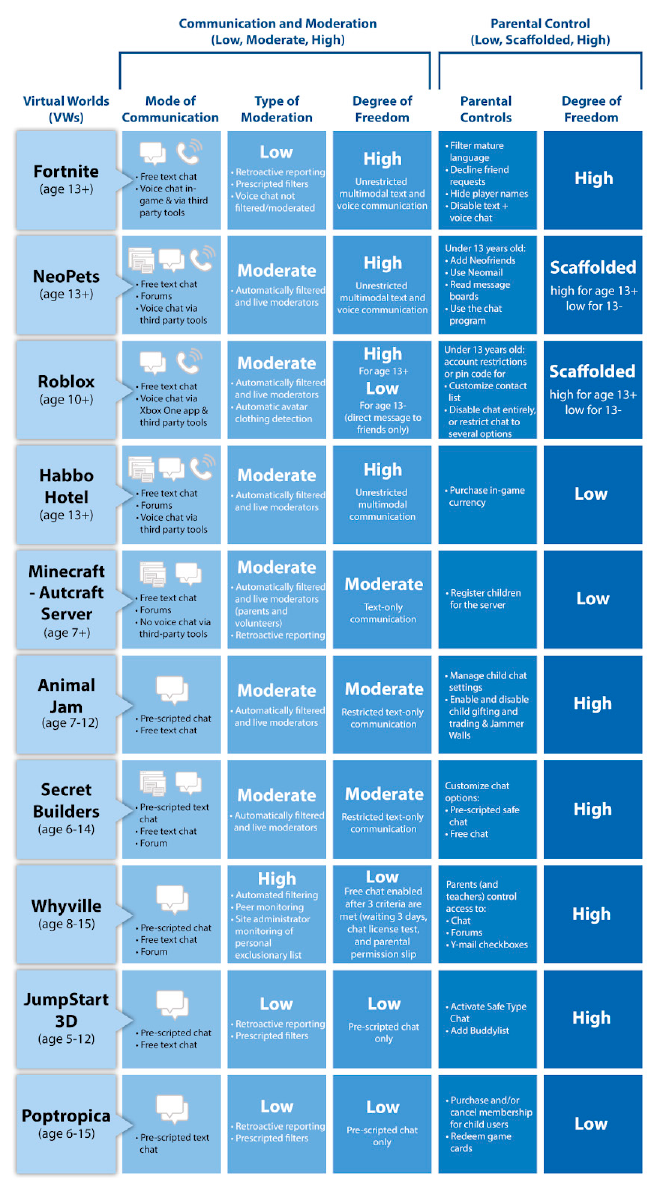
Figure 2. Degree of freedom for communication and moderation and parental control across 10 platforms (ordered by the degree of freedom for “communication and moderation” from high to low).